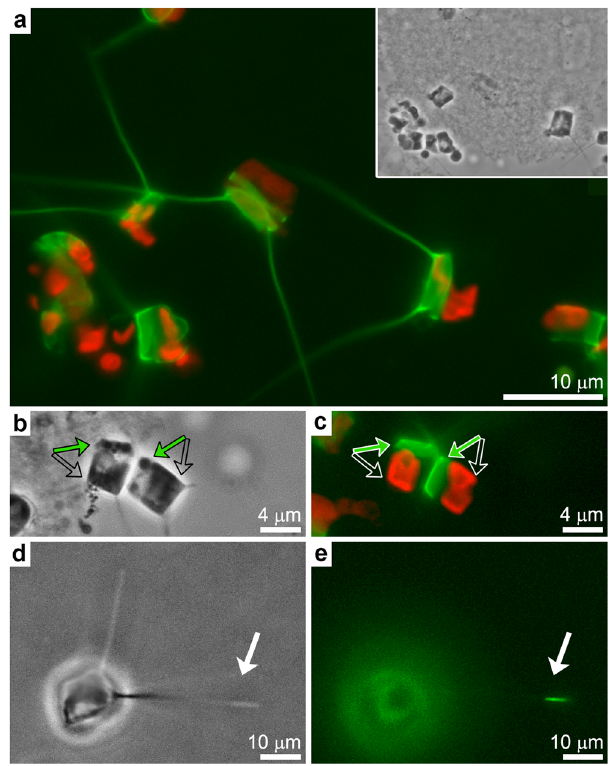
Fig. 2 Synchronization of seta formation. a A synchronized C. tenuissimus culture, where PDMPO fl uorescence (green) is observed only in one half of the cell wall. Chlorophyll auto fl uorescence is in red. Inset shows a bright- fi eld image of the cells. b , c Close-up view of two synchronized cells. Arrows show the newly formed and old valves (green and transparent arrows, respectively). d , e A single cell at the stage of seta formation immediately after the addition of PDMPO. Only the seta tip is labeled with PDMPO (arrows), indicating that this is the forming end of the seta. The rest of the cell is out of